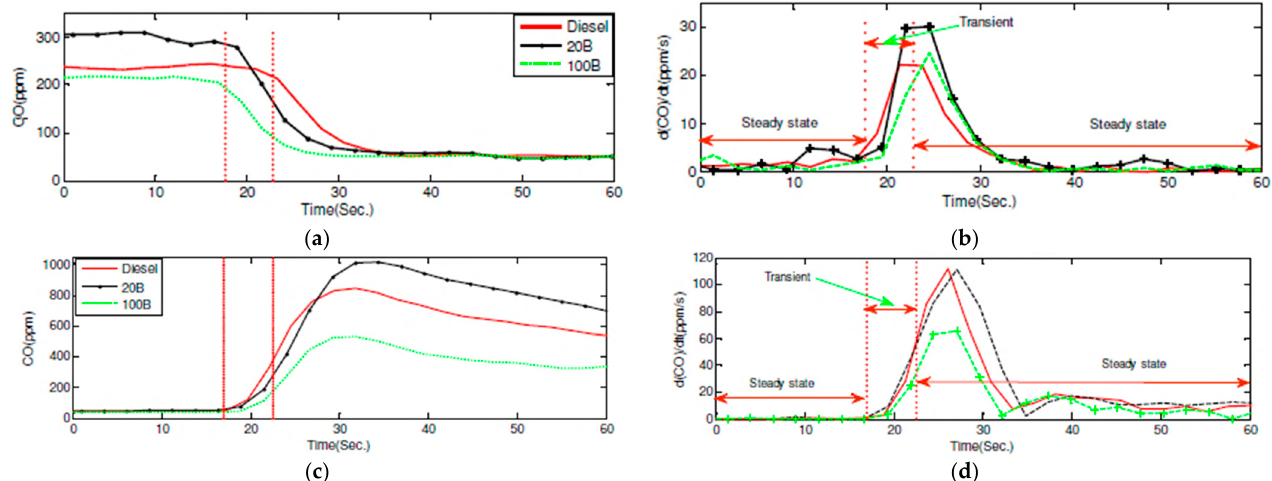
Figure 15. ( a ) Positive speed transient emission characteristics of CO in the CI engine running with the three fuels during positive speed transient; ( b ) corresponding rate of change of CO emission. ( c ) CO emission characteristics in CI engine running with the three fuels during negative speed transient; ( d ) corresponding rate of change of CO emission.